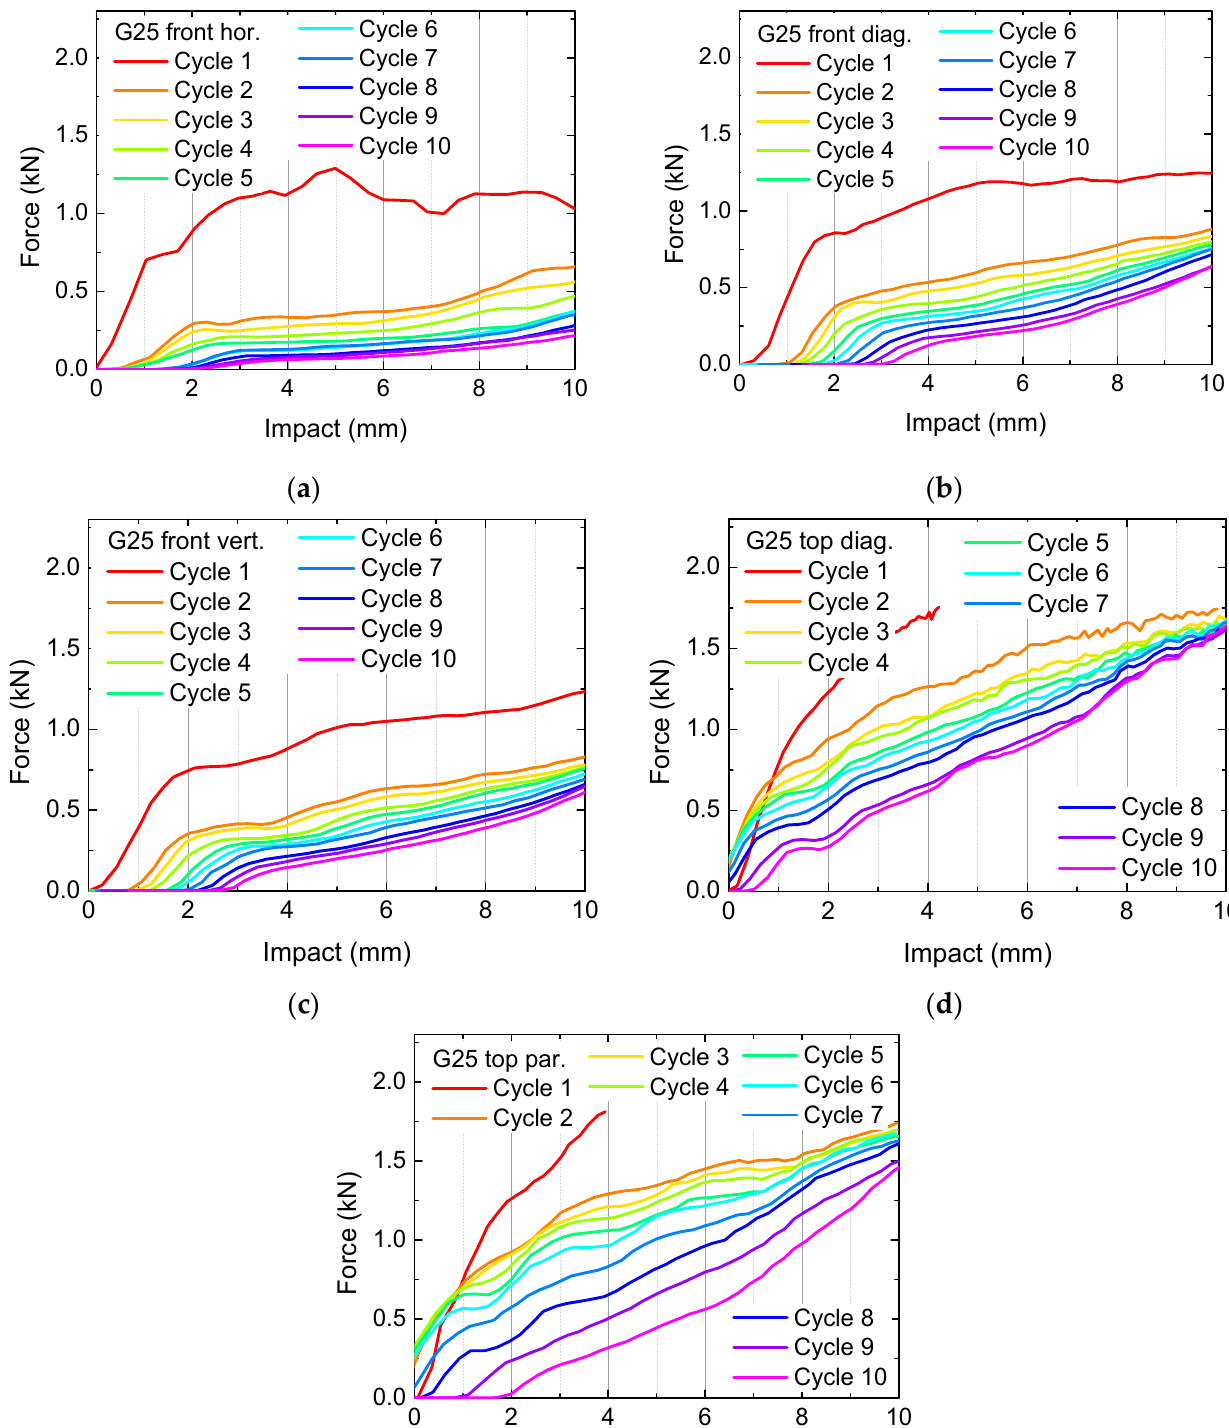
Figure 4. Quasi-static load tests in original state and after several test and recovery processes of samples G25: ( a ) front horizontal; ( b ) front diagonal; ( c ) front vertical; ( d ) top diagonal; ( e ) top parallel to the edges. The y-axes are scaled identically to Figure 3. In ( d , e ), the red lines are broken around 4 mm since to force limit was reached.